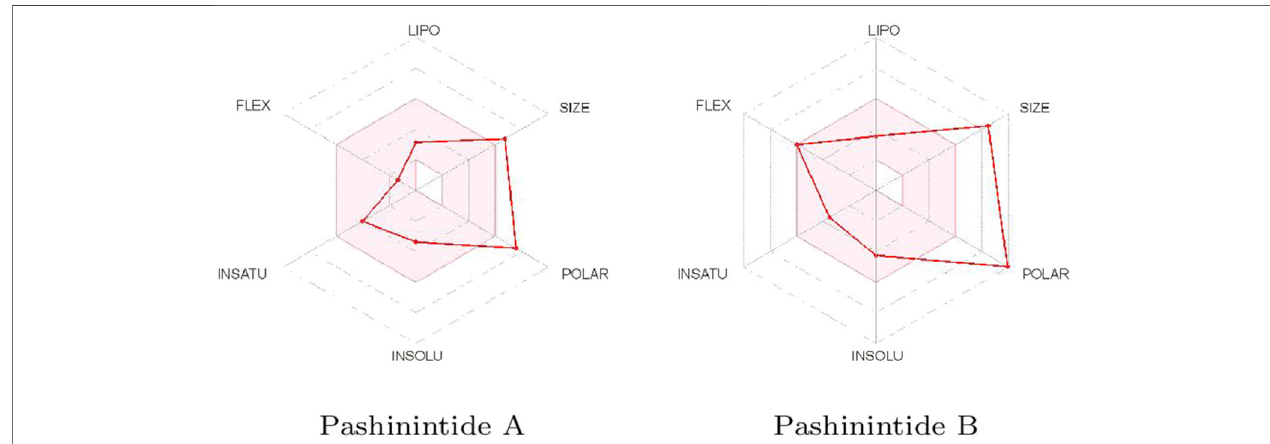
FIGURE 2 | Bioavailability radars of the Pashinintides A and B.